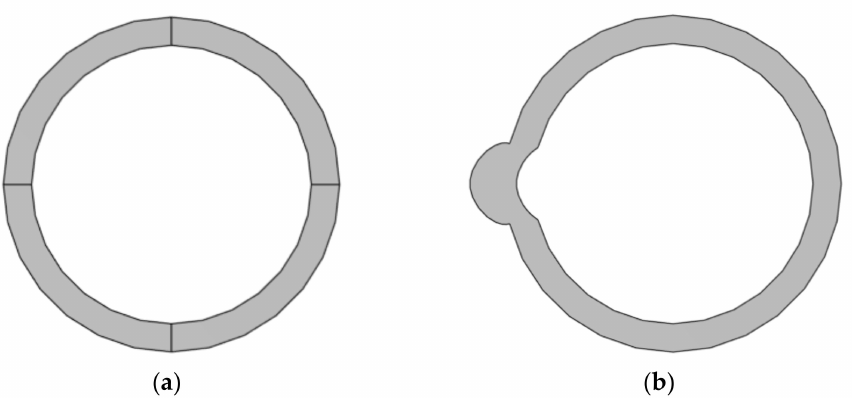
Figure 7. Winding deformation fault model. ( a ) Normal top view; ( b ) top view of the deformation.